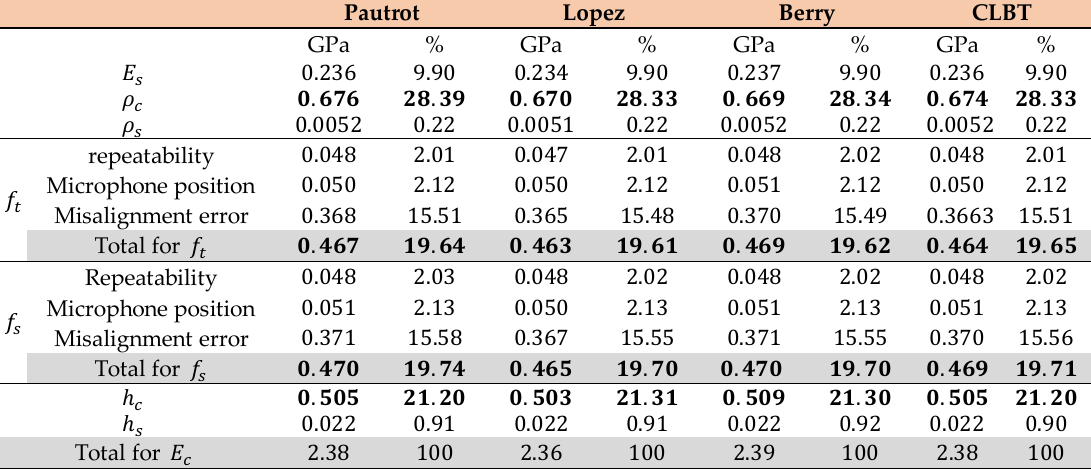
Table 1. Contribution of each uncertainty source (in GPa and %) on the coating Young’s modulus